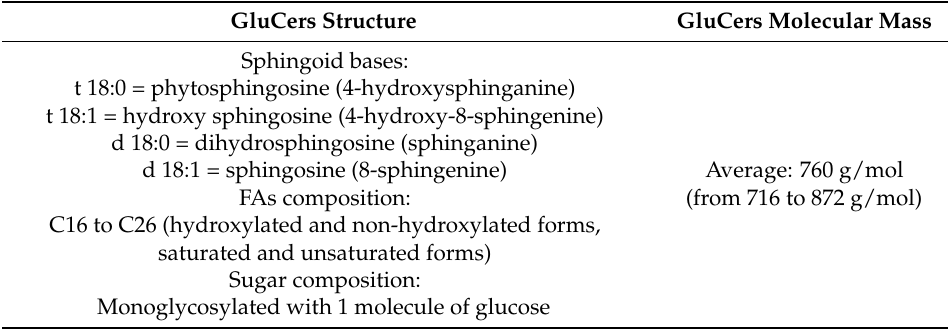
Table 2. GluCers identified and characterized by UPLC-ESI-MS/MS.